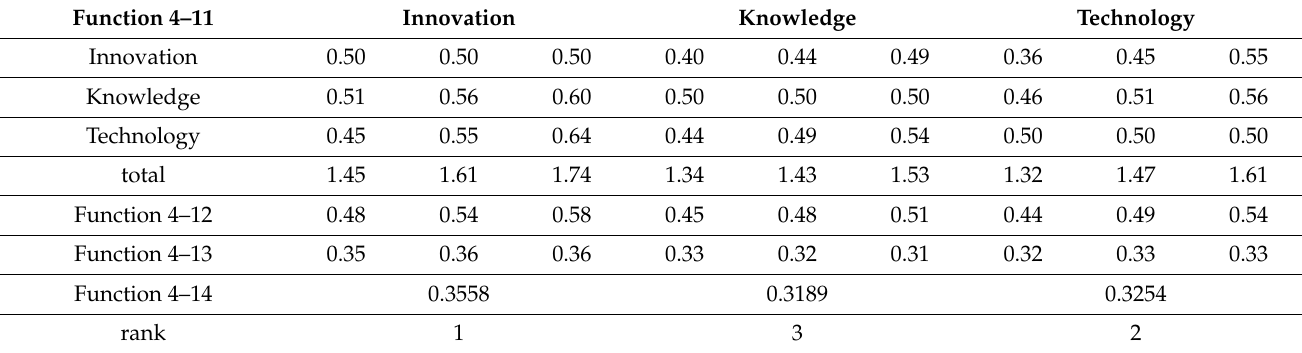
Table A19. Hotels’ weights of attributes of the epistemic